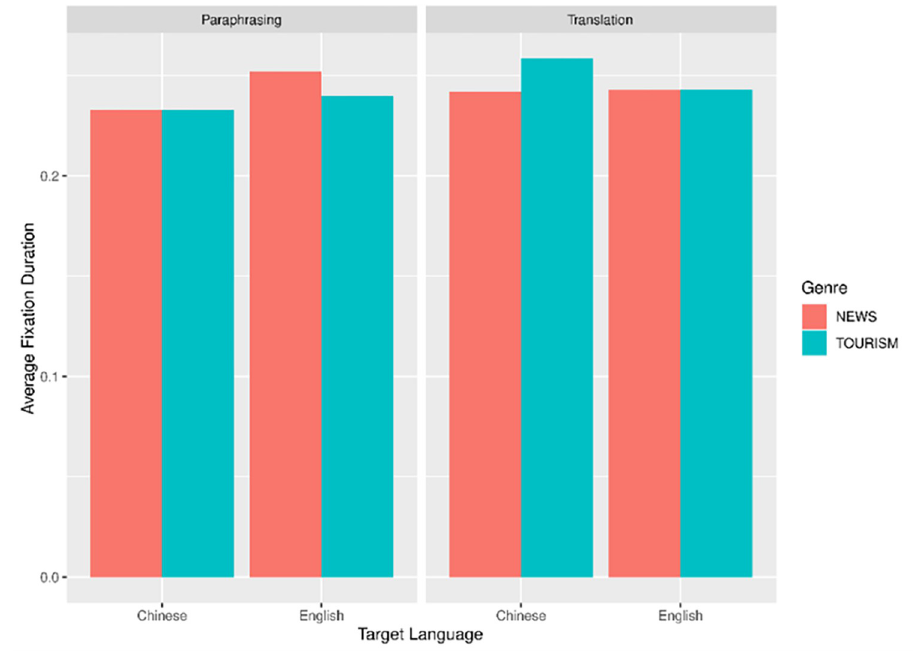
Fig 2. Average fixation duration in ST.